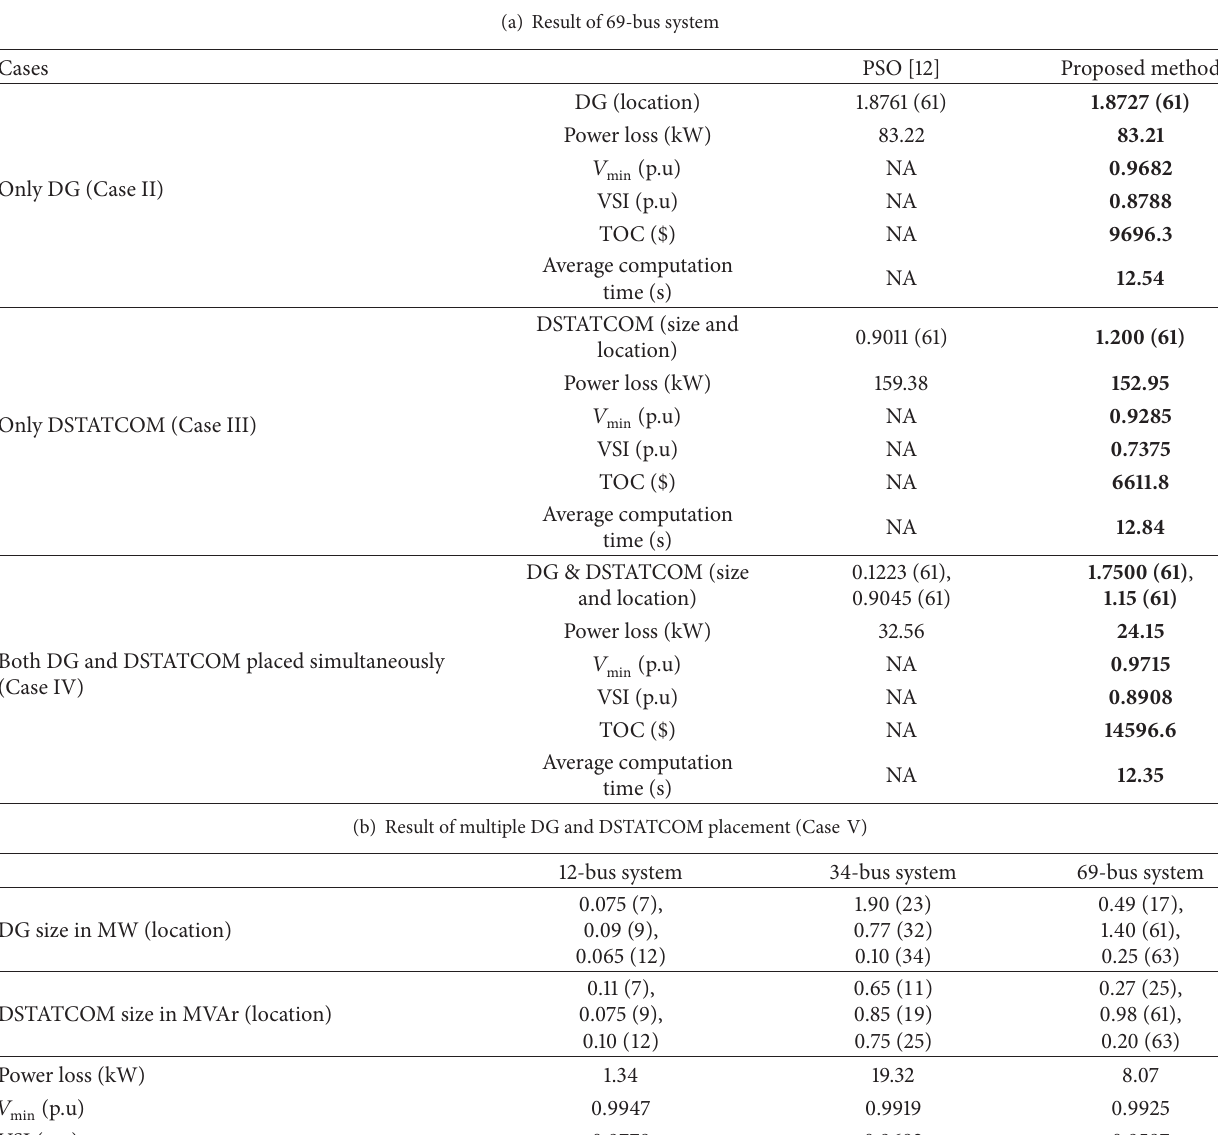
(a) Result of 69-bus